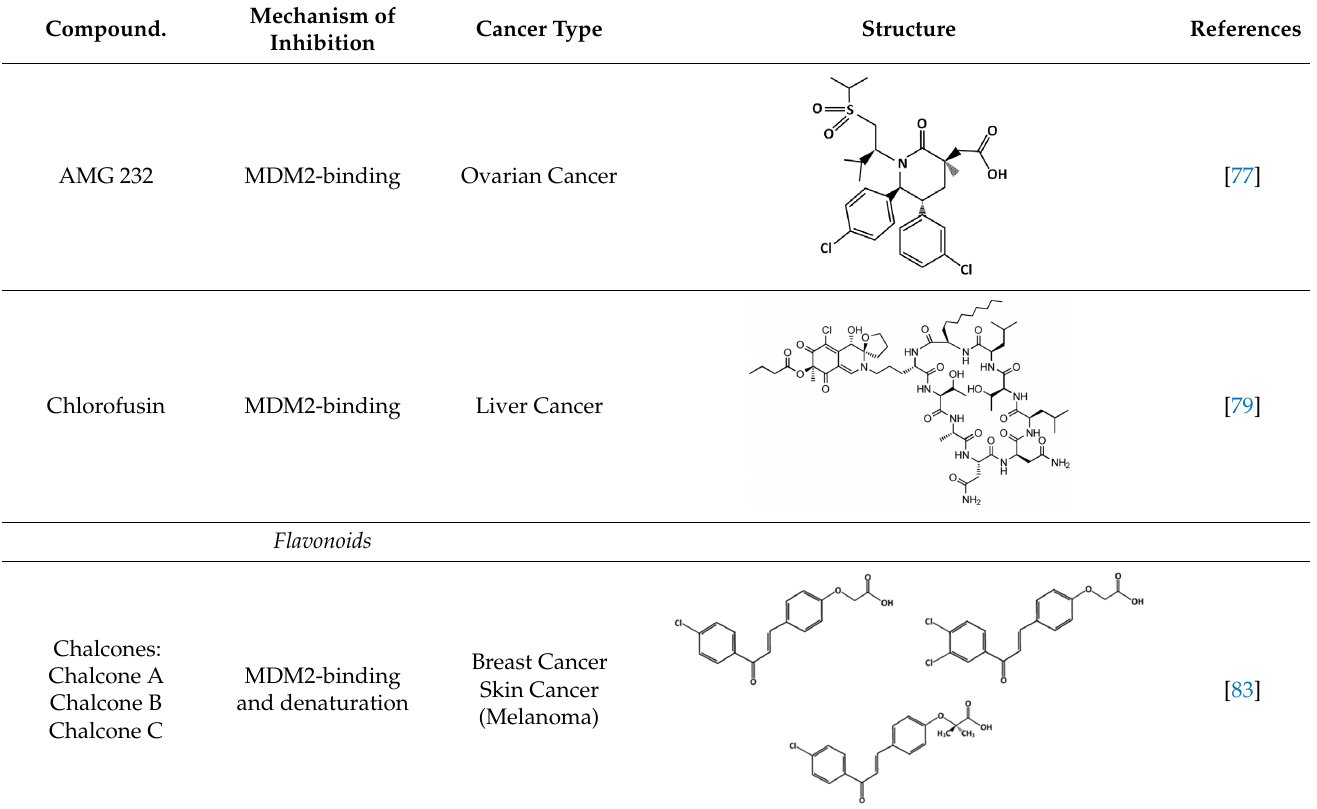
Table 1. List of compounds that target p53-MDM2 interaction, either via MDM2-binding or phos- phorylation of p53.